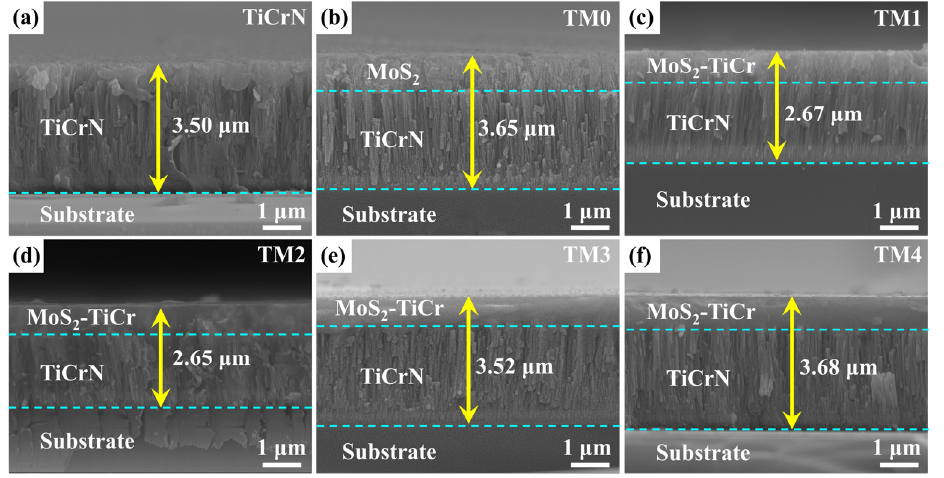
Figure 5. Cross-sectional morphology of ( a ) TiCrN, ( b ) TM0, ( c ) TM1, ( d ) TM2, ( e ) TM3, and ( f ) TM4 coatings.